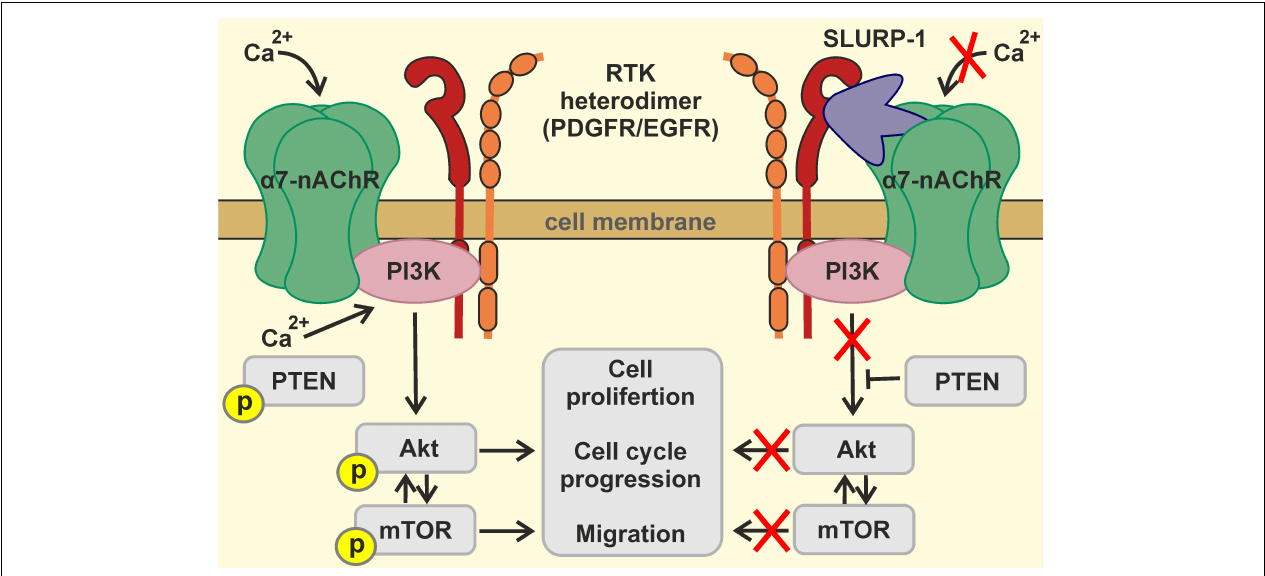
FIGURE 8 | Scheme illustrating the mechanism of SLURP-1 action in A549